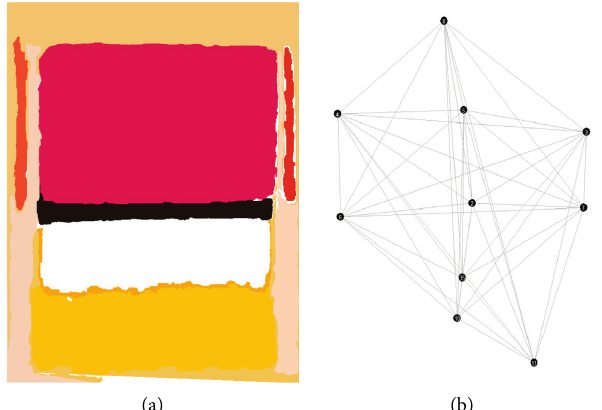
Figure 8: Rothko’s “Violet, Black, Orange, Yellow on White and Red” (1949).10 simple regions and complete graph based on the centers of every region's straight